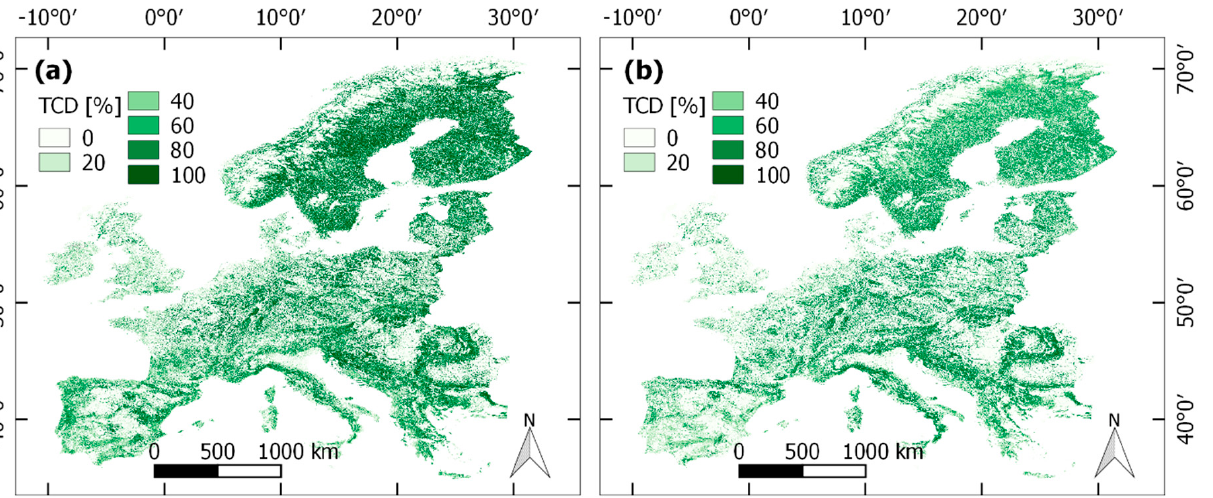
Figure 11. Overview of the tree cover density (TCD) maps from ( a ) Sentinel-1, ( b ) Copernicus High Resolution Layers (HRL) and ( c ) the difference map between the two datasets (Copernicus HRL map was subtracted from Sentinel-1 TCD map).